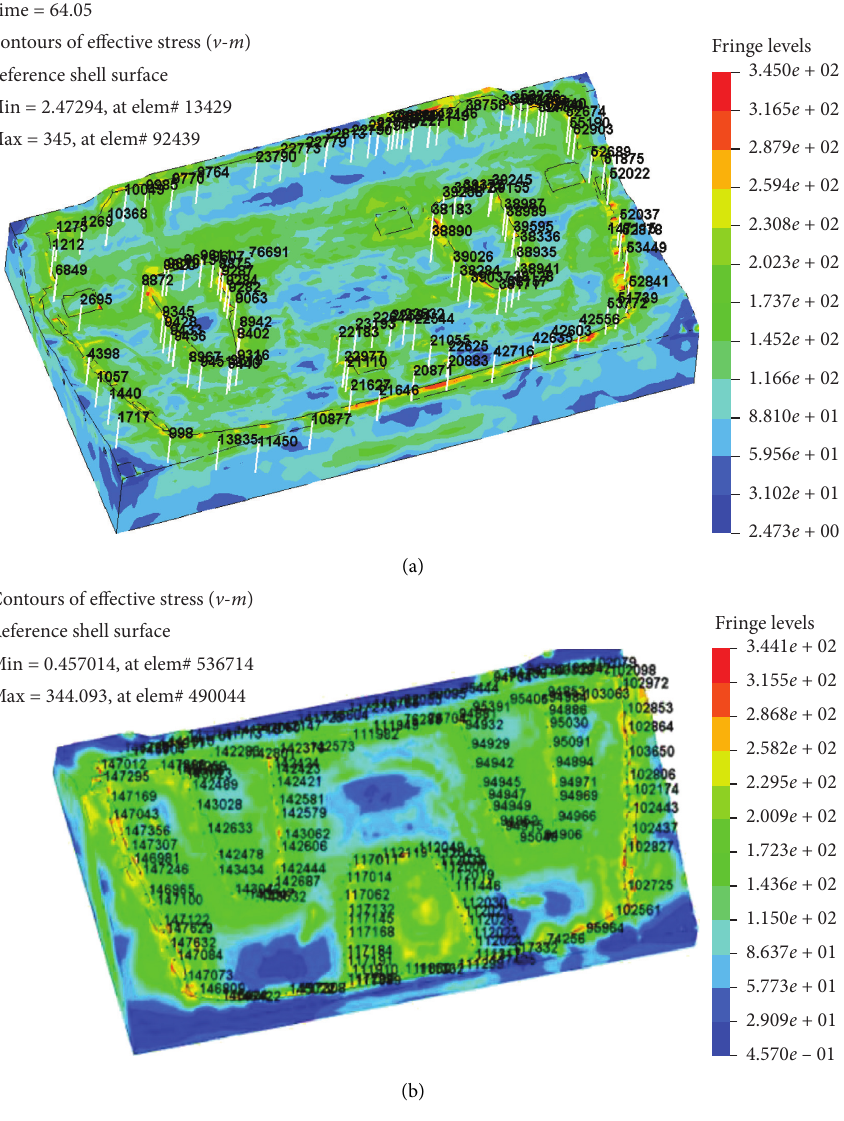
Figure 9: Derived node displacement result graph. (a) Nodal displacement results derived from the die. (b) Nozzle displacement results derived from punch.